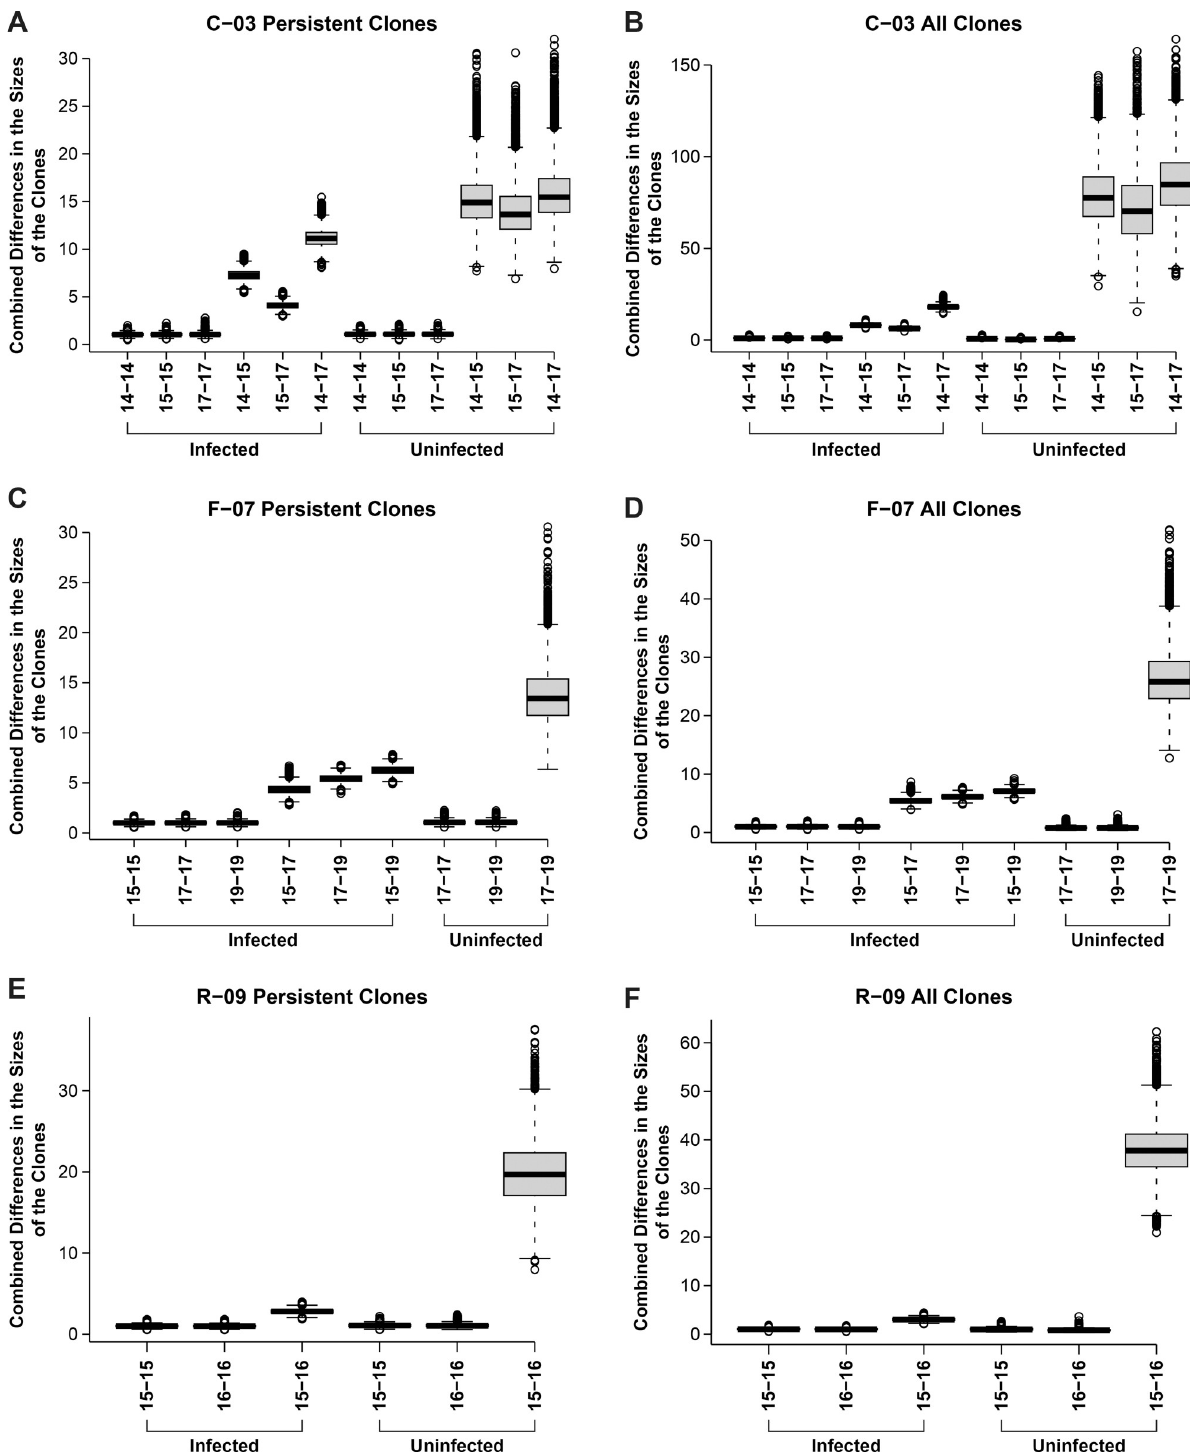
Fig 3. Overall stabilities of clones of infected and uninfected T cells. For each pair of time points for each donor, we determined the differences in the sizes of the each of clones in the dataset. For the comparisons of the differences in the sizes of the clones of infected cells, the 100 largest clones were used and the sizes of the clones were determined as described in the S1 Text. For the uninfected cells, a dataset of clones of a similar size was compiled, and the stability calculations were done using randomly sampled groups of 100 uninfected clones. The uncertainties in the measured sizes of the clones in each of the datasets was determined by doing a within dataset comparisons which are shown in the figure as comparisons for the same